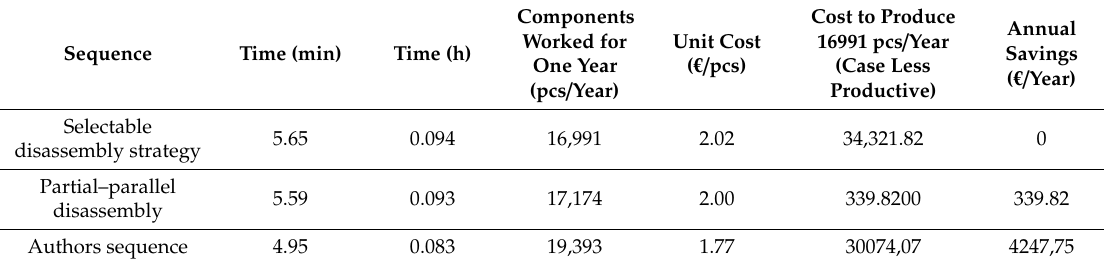
Table 5. Results and comparison among the sequences studied and